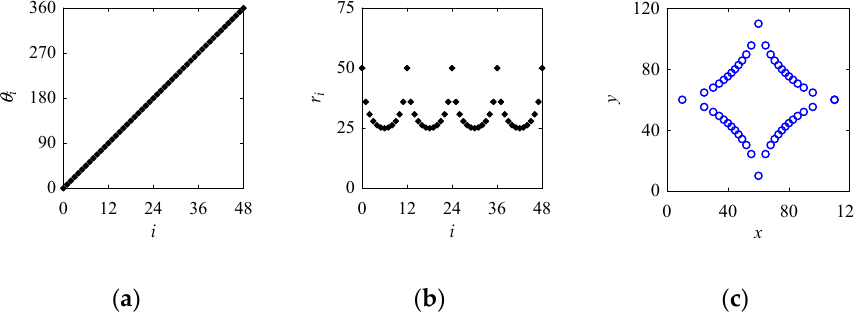
Figure 8. Settings for an astroid using the PCA. ( a ) Input1: θ i ; ( b ) Input2: r i ; ( c ) Output: Point cloud.